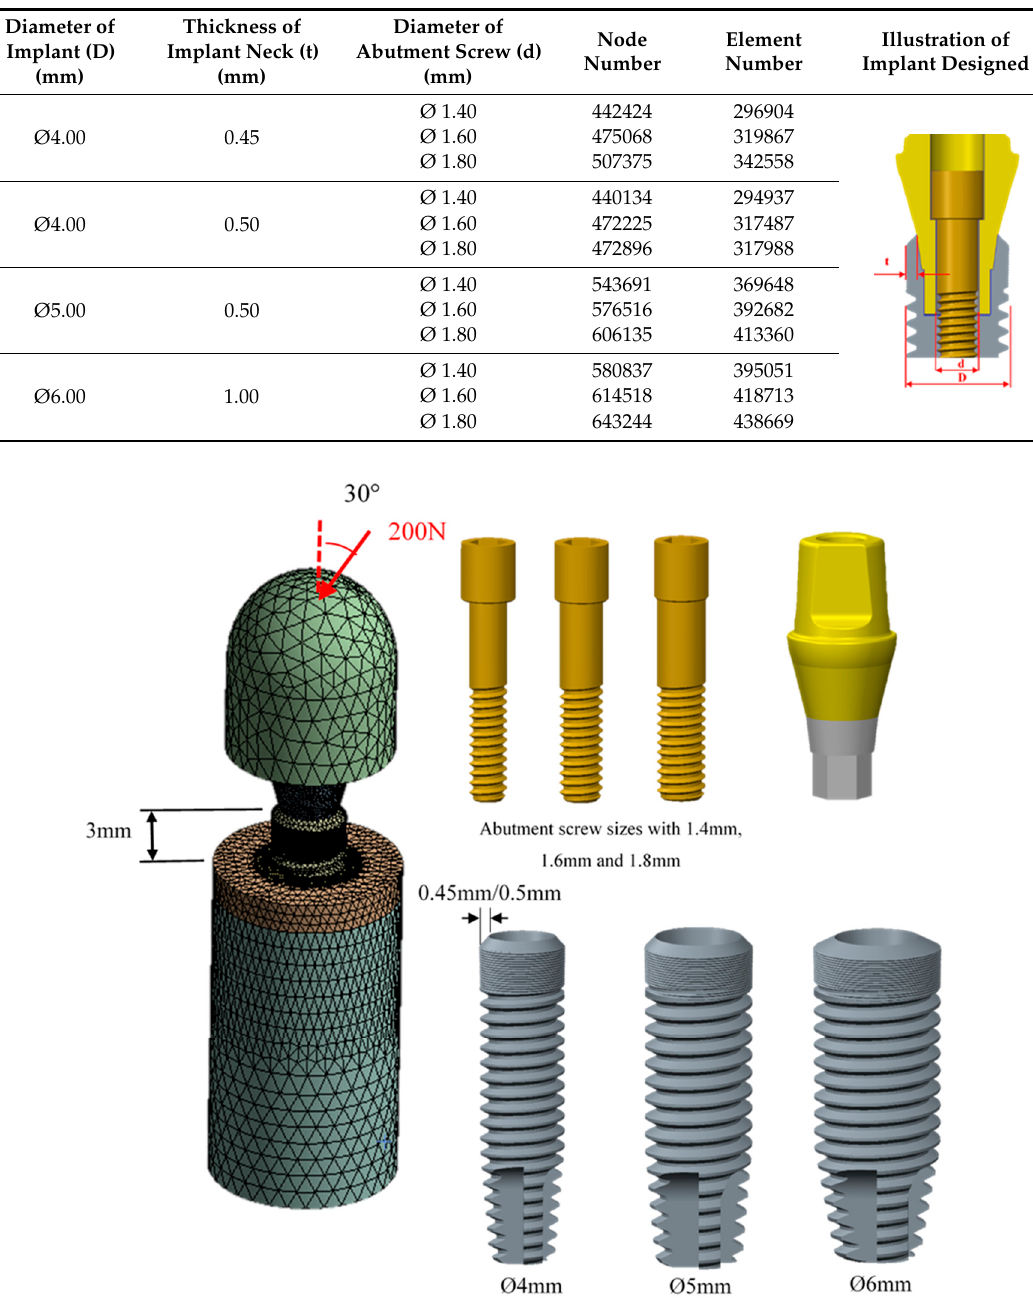
Table 1. Combinations of implant sizes ( D ), implant neck wall ( t ), and diameter of abutment size ( d ) and their corresponding finite element (FE) models with node/element numbers used in this study.